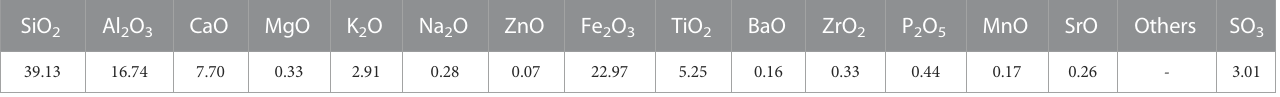
TABLE 1 Chemical analysis determined by XRF of industrial waste: fl y ashes (FA) (wt%). SiO 2 Al 2 O 3 CaO Others SO